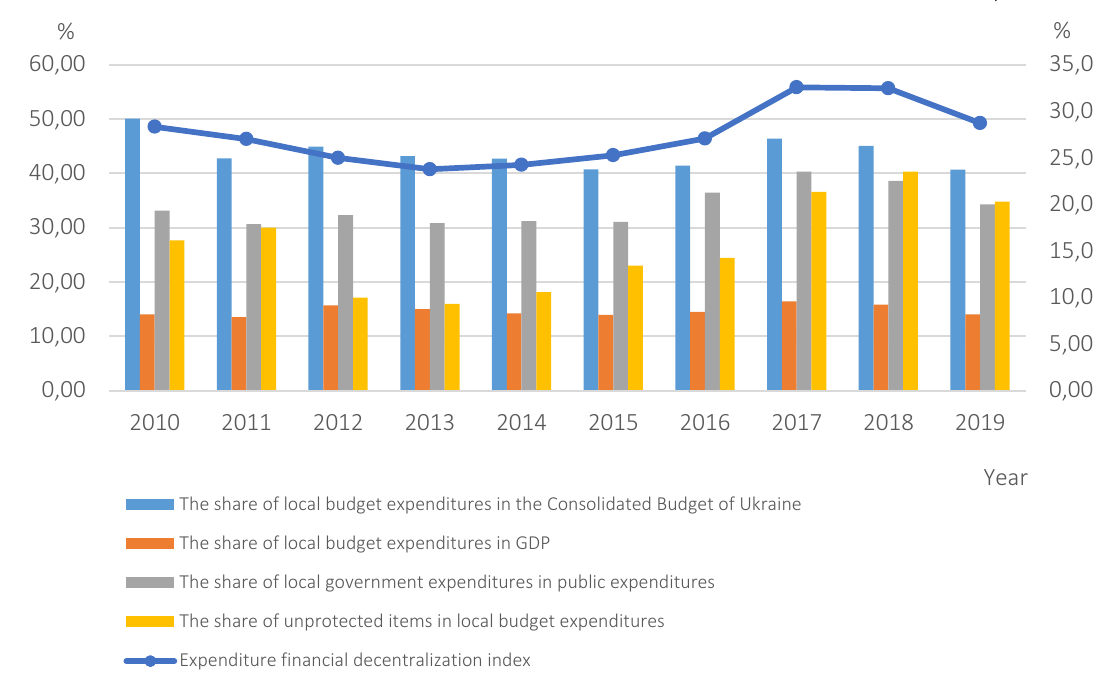
Figure 5. Dynamics of the decentralization index of local budget expenditures in Ukraine for